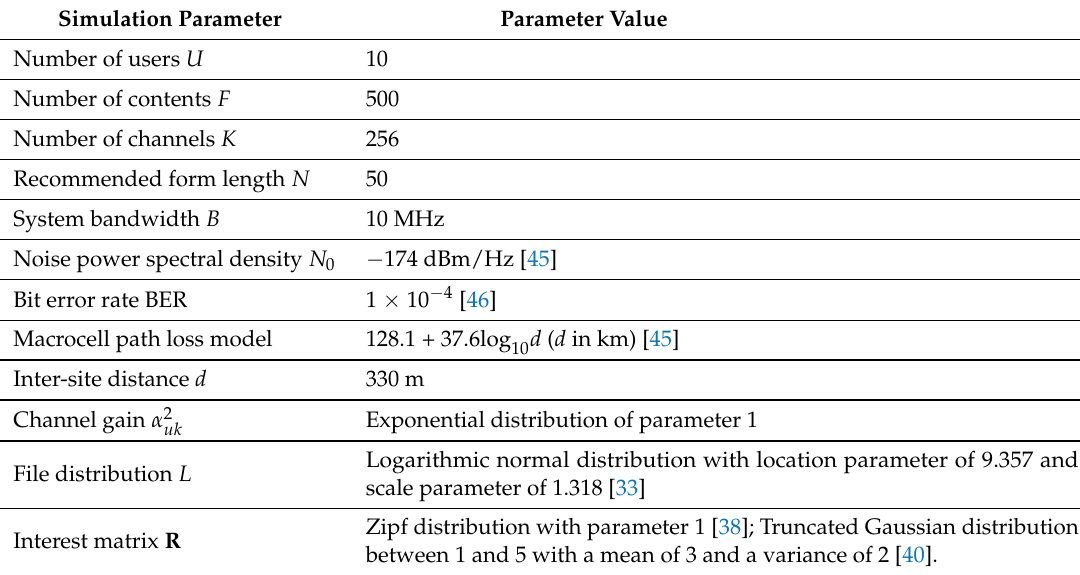
Table 1. Simulation